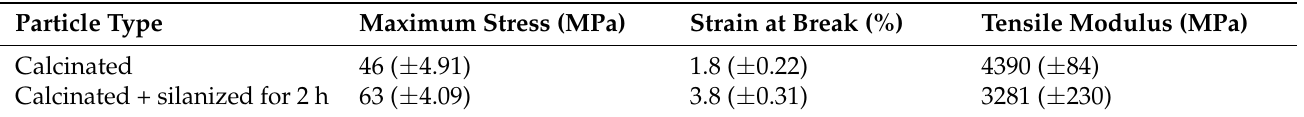
Table 4. Average strength and strain at break of PA6/glass particles composites specimens containing calcinated particles and calcinated + 2 h-silanized